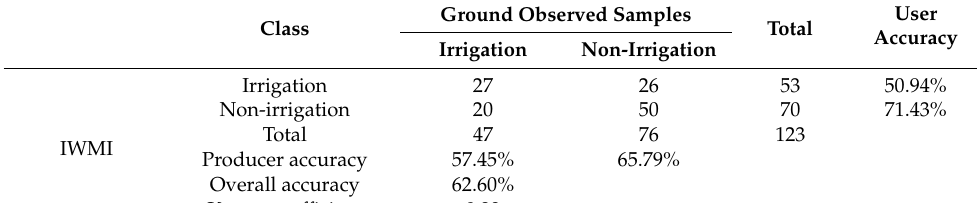
Table 3. Validation of four irrigation datasets at 123 field samples.